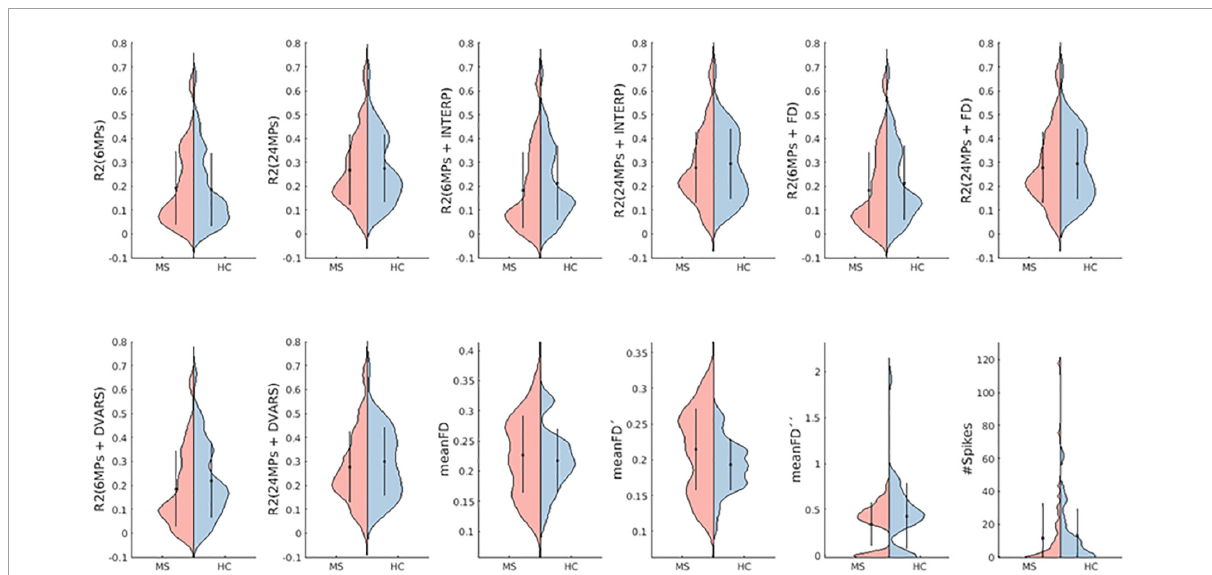
FIGURE3 Motion quantification. Violin plots of motion metrics for both groups. R 2 describes the amount of BOLD signal variation (without motion correction) explained by each set of regressors describing motion. Higher values of R 2 means better performance of the method. meanFD is the mean framewise displacement, meanFD’ is the mean FD without considering motion outliers, meanFD” is the mean FD considering only the motion outliers. Higher values indicate more movement. #Spikes is the number of motion spikes. Red and blue represent the groups of MS patients and HC, respectively. The dots and vertical lines in each group represent the mean ± standard deviation of the values of the three runs. Both distributions are quite similar, evidencing no differences in motion metrics between groups, as supported by the ANOVA.